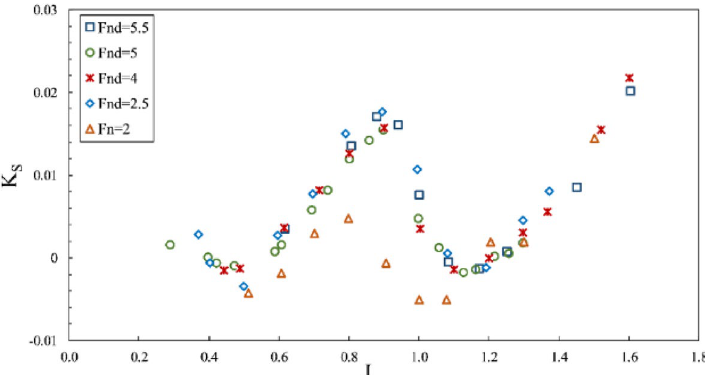
Figure 13. Side force coefficient in propeller direction in different Froude numbers ( I = 0.4, α = 3 ◦ ).